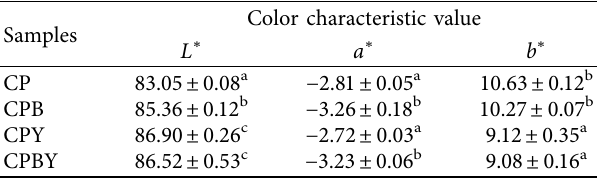
Table 2: The color features of four samples of fermented